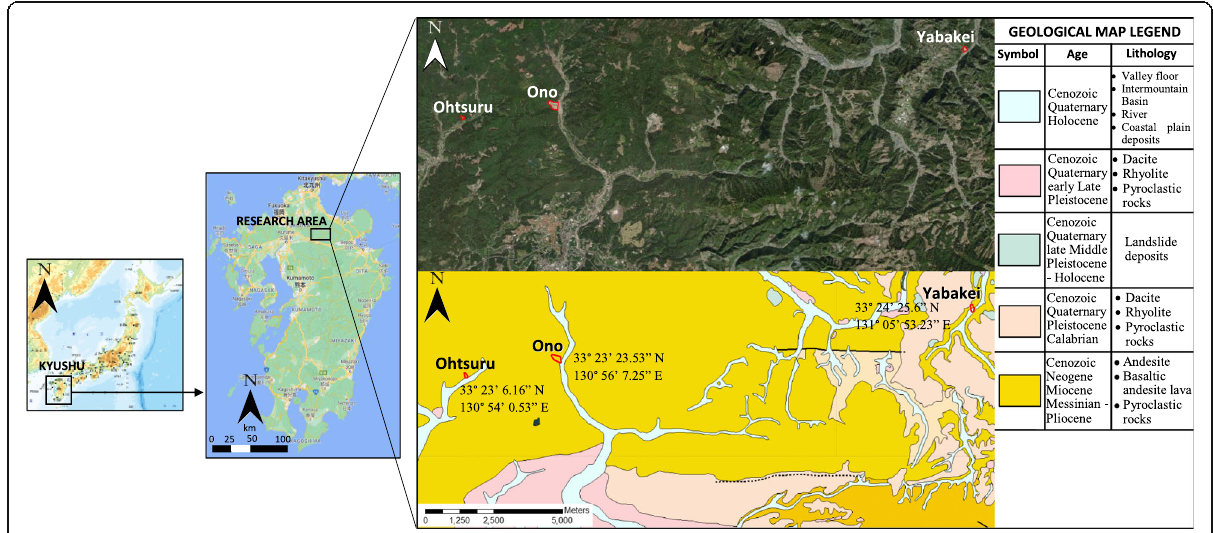
Fig. 1 Location of the landslides and geological map in this study (Geology Survey of Japan